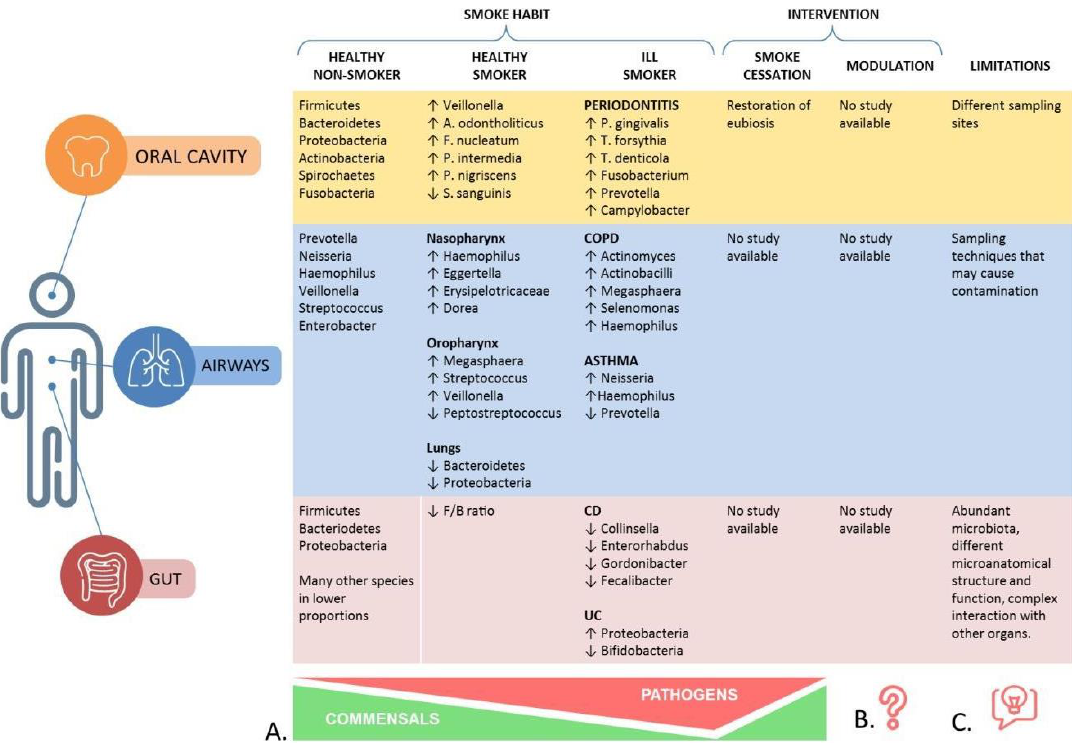
Figure 2. Main findings of this review. ( A ) The model of smoke-related dysbiosis in different body regions, characterized by a progressive depletion of beneficial commensals and an increase of path- ogens. ( B ) Effects on smoke-related dysbiosis after different interventions, such as smoking cessa- tion and modulation of the microbiota composition (prebiotics, probiotics, fecal transplantation). ( C ) Main limitations found in the design of studies available on the topic.